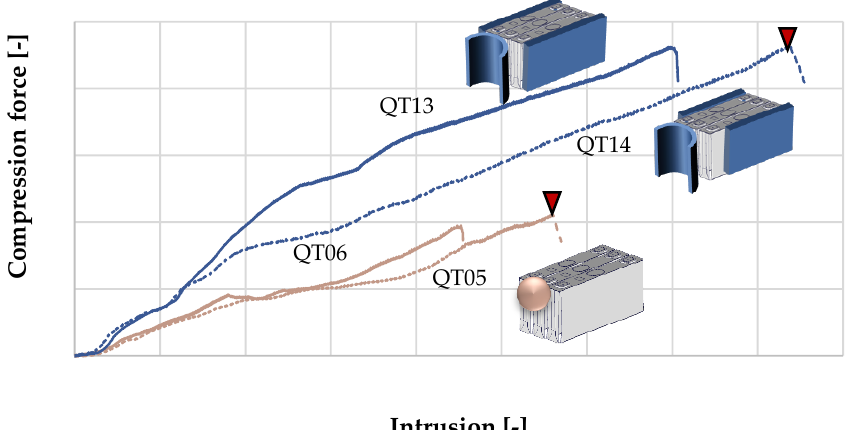
Figure 5. Compression force over intrusion in v-direction (red triangle mark event. No triangle, no event).